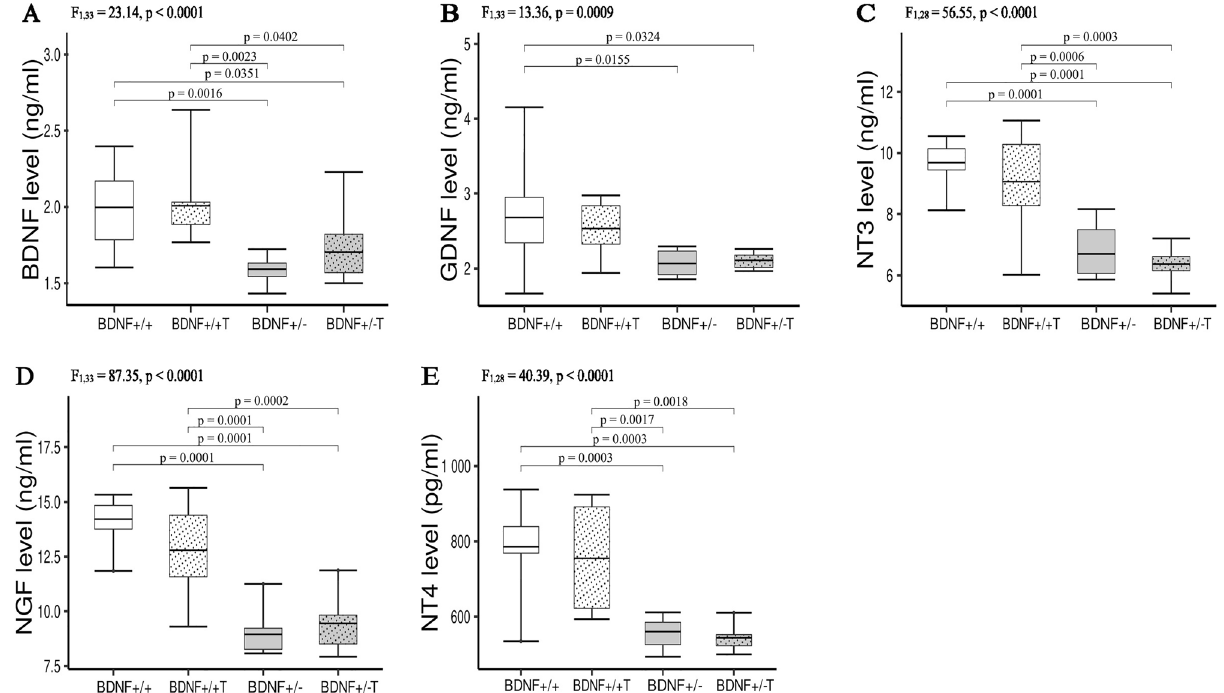
Figure 1. The concentrations of BDNF ( A ), GDNF ( B ), NT3 ( C ), NGF ( D ) and NT4 ( E ) in the serum of Bdnf +/+, Bdnf +/+ T, Bdnf +/− , and Bdnf +/− T rats. The bars indicate the mean values, box-plots ± 25% of the dataset, and whiskers ± SD. Differences between the Bdnf +/+ and Bdnf +/− animals, as well as between the Bdnf +/+ T and Bdnf +/− T groups are indicated above the plots (two-way ANOVA with genotype and training as fixed factors with Tukey’s HSD post-hoc